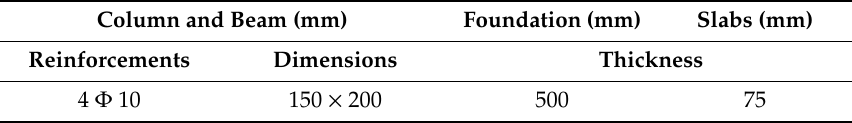
Table 1. Dimensions and section properties assigned to the RC building